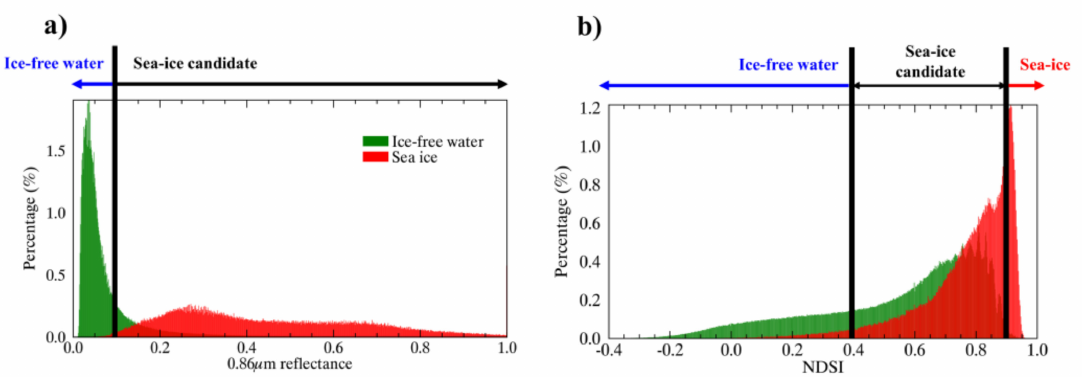
Figure 5. Distribution of ( a ) Himawari-8 / AHI-based R 0.86 and ( b ) NDSI showing thresholds for sea ice / ice-free water in MODIS sea ice extent (MOD29) data. Black lines in figure are set empirically according to the value distribution of each index ( R 0.86 and